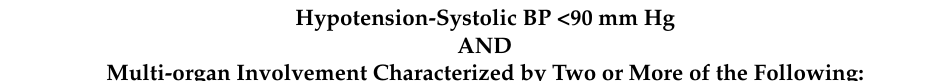
Table 2. Abbreviated Adult Case Definition for Streptococcal Toxic Shock Syndrome (CDC